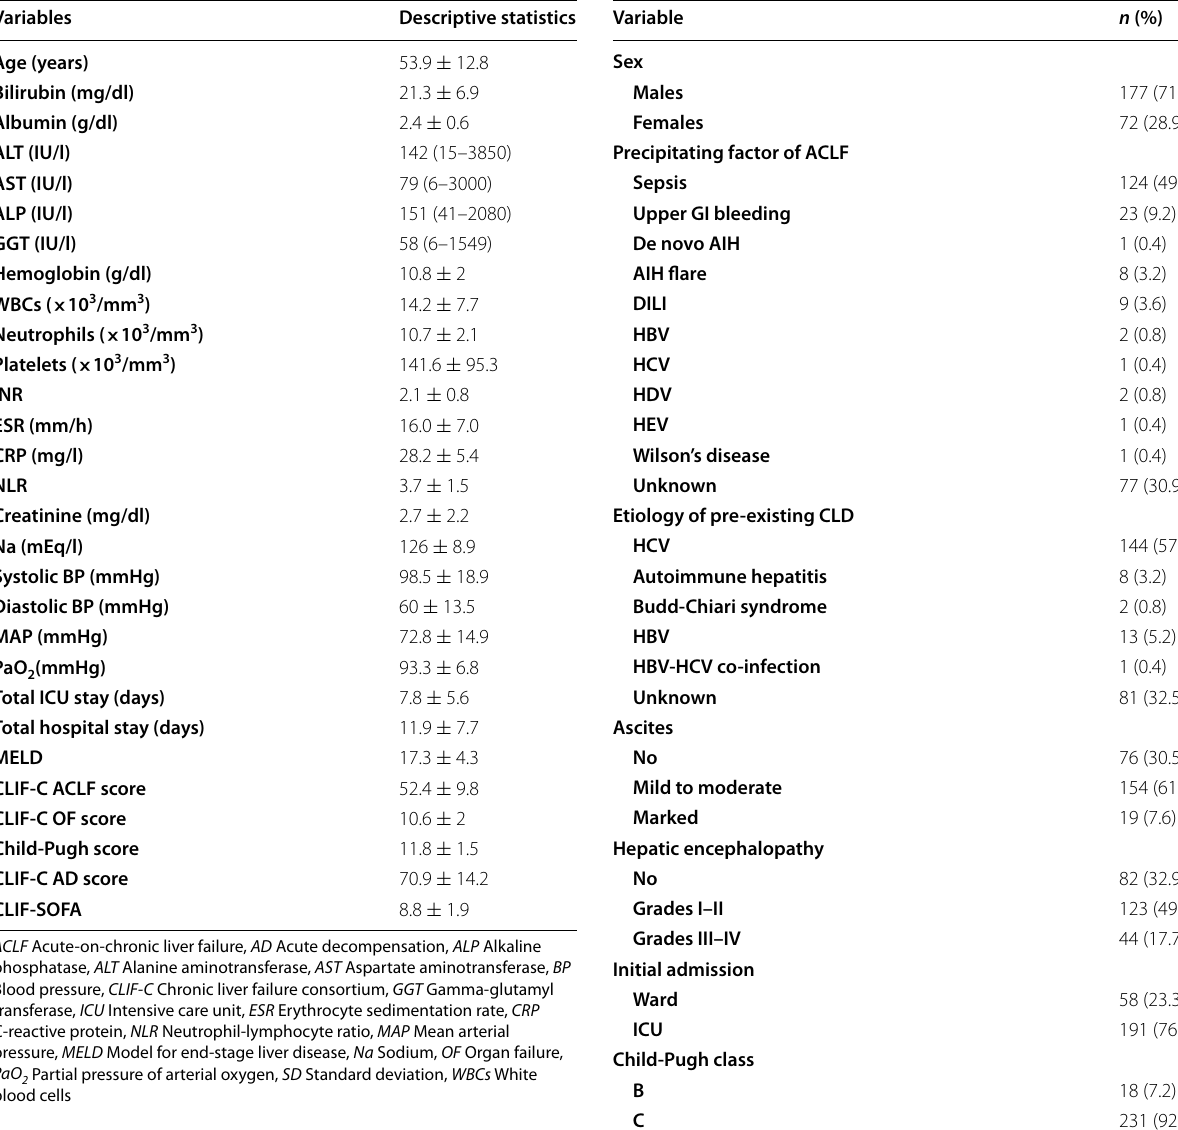
Table 2 Baseline characteristics of the studied